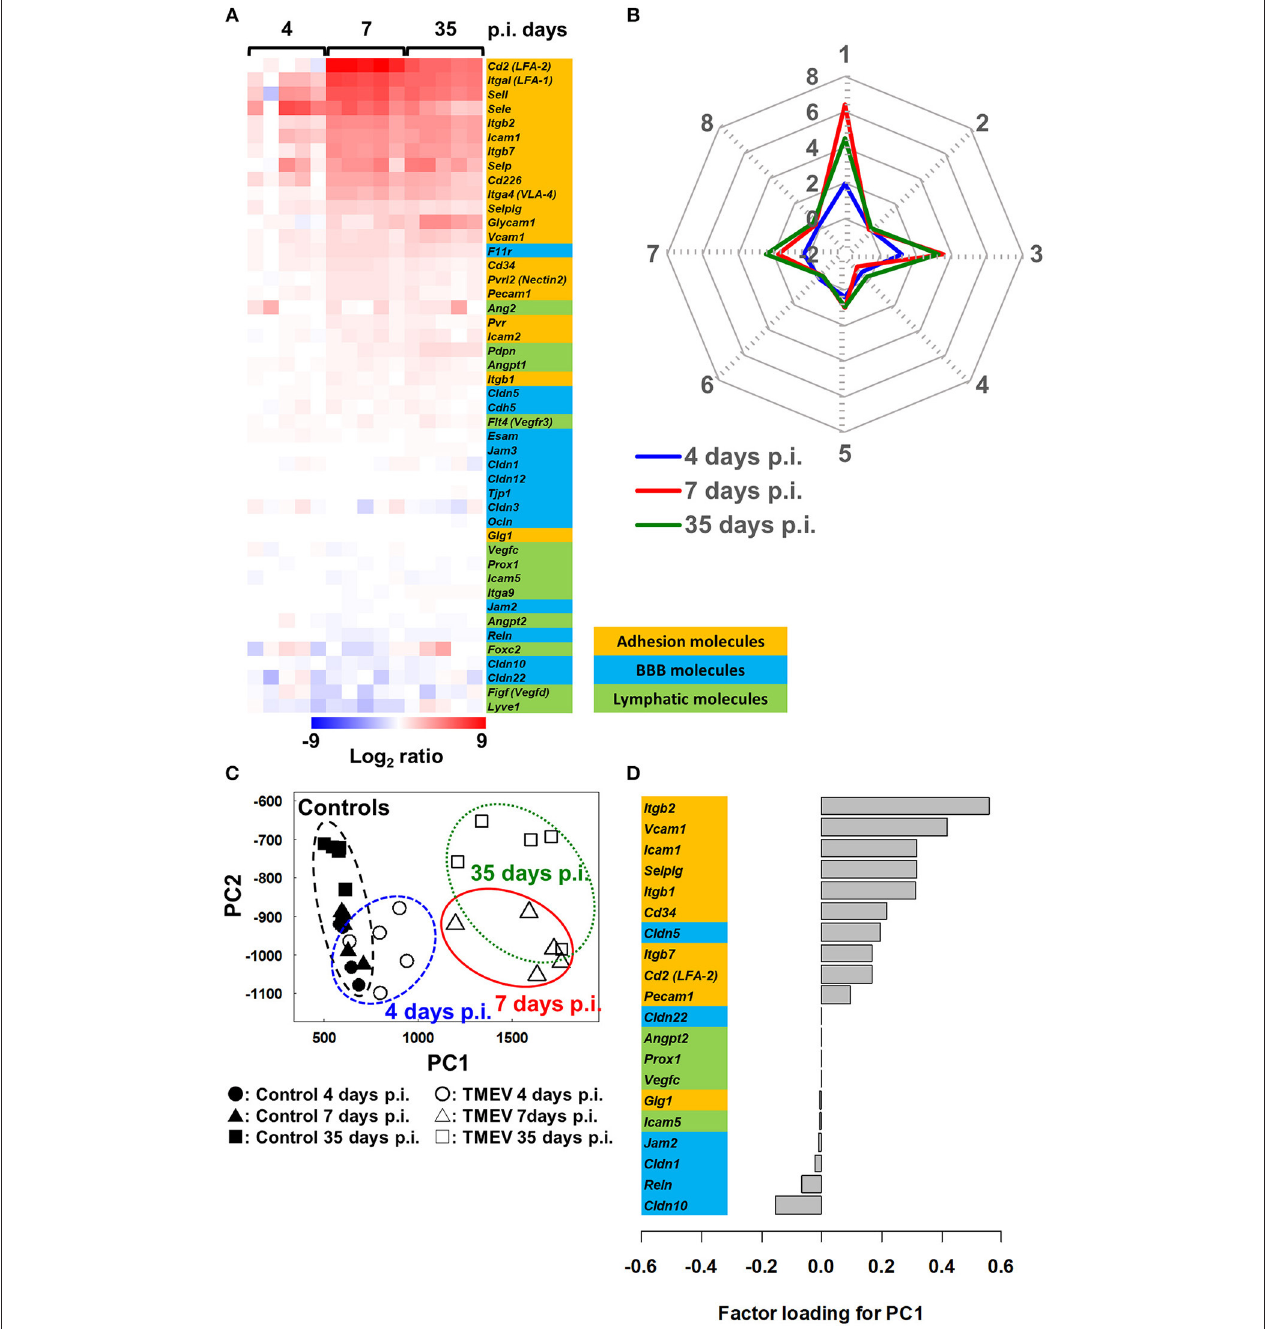
FIGURE 6 | Bioinformatics analyses of gene expression of three components associated with spinal cord inflammation in TMEV infection, 4 (prior to cell infiltration), 7 (acute polioencephalomyelitis) and 35 (TMEV-IDD) days p.i. (61). (A) We drew a heat map, using mRNA data of 20 adhesion molecules, 14 BBB molecules, and 12 lymphatic molecules listed in Figure 5 (total 46 genes). Most adhesion molecule genes were upregulated 7 and 35 days p.i., while only a few adhesion molecules were upregulated 4 days p.i. BBB and lymphatic molecules showed no change or slight downregulation. (B) Radar chart based on the values of cluster centers from k -means clustering ( Supplementary Table 4 ). The number of each vertex is the cluster number (clusters 1 to 8), whereas the number along the axis ( − 2 to 8) are log ratios compared with mock-infected controls. Radar chart showed that the expression patterns of sets of genes were similar between days 7 and 35 p.i. Upregulated genes were categorized mostly in clusters 1, 3, and 7. (C) PCA of the 46 genes listed in Figure 5 separated controls/day 4 p.i. samples vs. days 7 and 35 p.i. samples based on PC1 values (proportion of variance was 85.9%), which reflect CNS cell infiltration. (D) Factor loading for PC1 showed that upregulation of adhesion molecules was associated with CNS inflammation, while downregulation of BBB and lymphatic molecules may play a minor role.